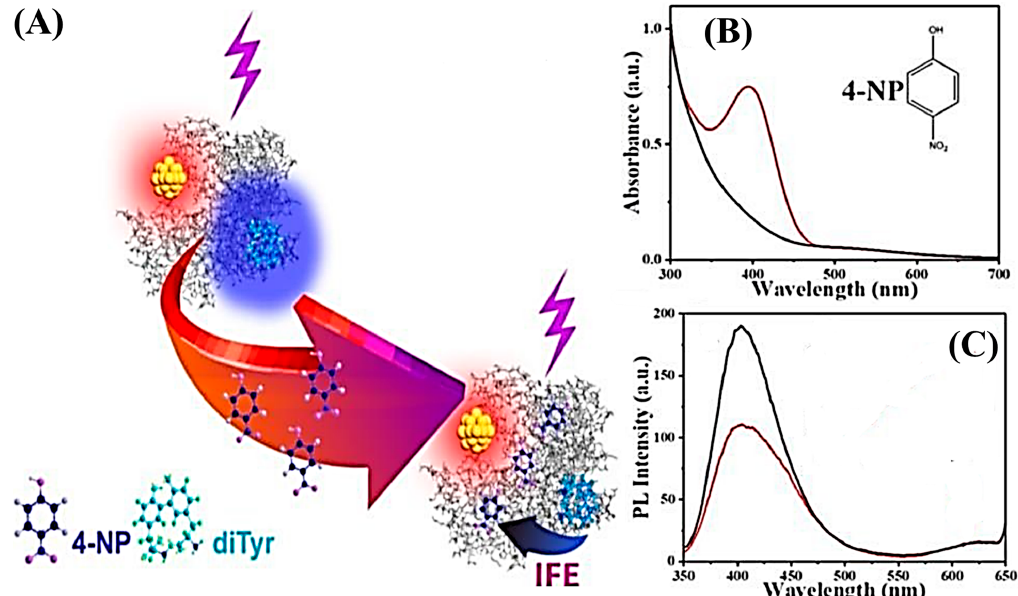
Figure 5. ( A ) Schematic illustration of AuNC-assisted and inner filter effect (IFE)-based fluorescence detection of 4-nitrophenol (4-NP) by means of selectively induced quenching of 410 nm fluorescence intensity of residual di-tyrosine (diTyr) using fluorescence intensity of AuNCs [85] at 630 nm in a complex of bovine serum albumin (BSA)-stabilized AuNCs. ( B ) UV/Vis spectroscopy of AuNCs@BSA before and after 4-NP addition, illustrated by a black line and a red line, respectively. ( C ) Under excitation at 330 nm, photoluminescent emission spectroscopy of AuNCs@BSA before and after 4-NP addition is demonstrated by a black line and a red line, respectively. Adapted from [85].